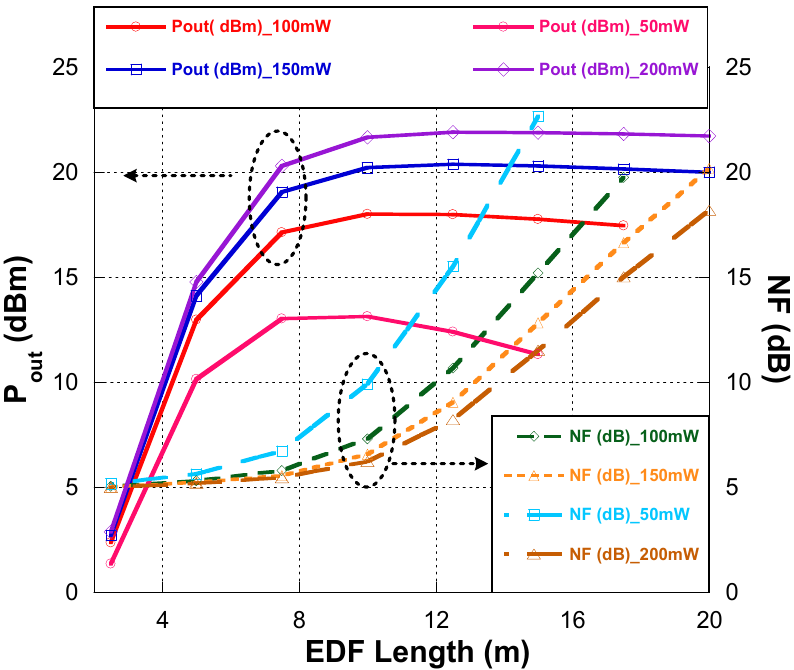
( b ) Figure 8. Simulation setup of a backup optical amplifier for ROA 1 : ( a ) detailed setup and ( b ) simpli- fied setup (ATT: attenuator, RBW: resolution bandwidth, OSA: optical spectrum analyzer).